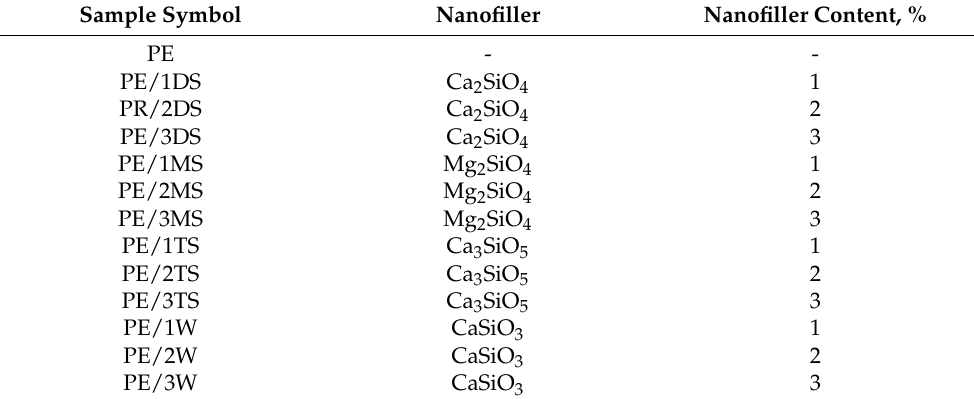
Figure 1. Reactions of wollastonite nanofillers synthesis by modified Peccini synthesis reaction [32]. Mechanical mixing of epoxy resin and various ratios of synthesized silicates was used to create the composite materials. Table 2 lists the fillers used, as well as the filler content and sample symbols. Table 2. Sample symbols, nanofillers and nanofiller content.